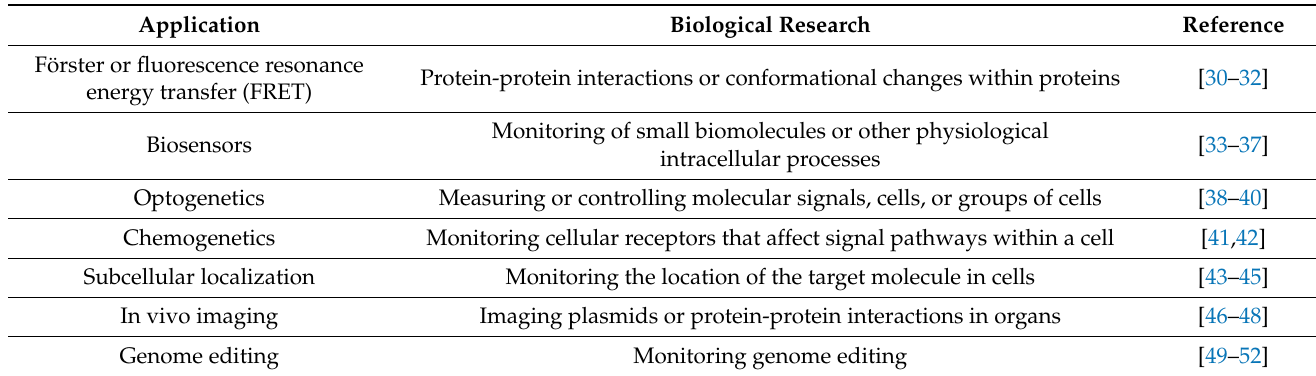
Table 1. Application of fluorescent proteins in biological research.